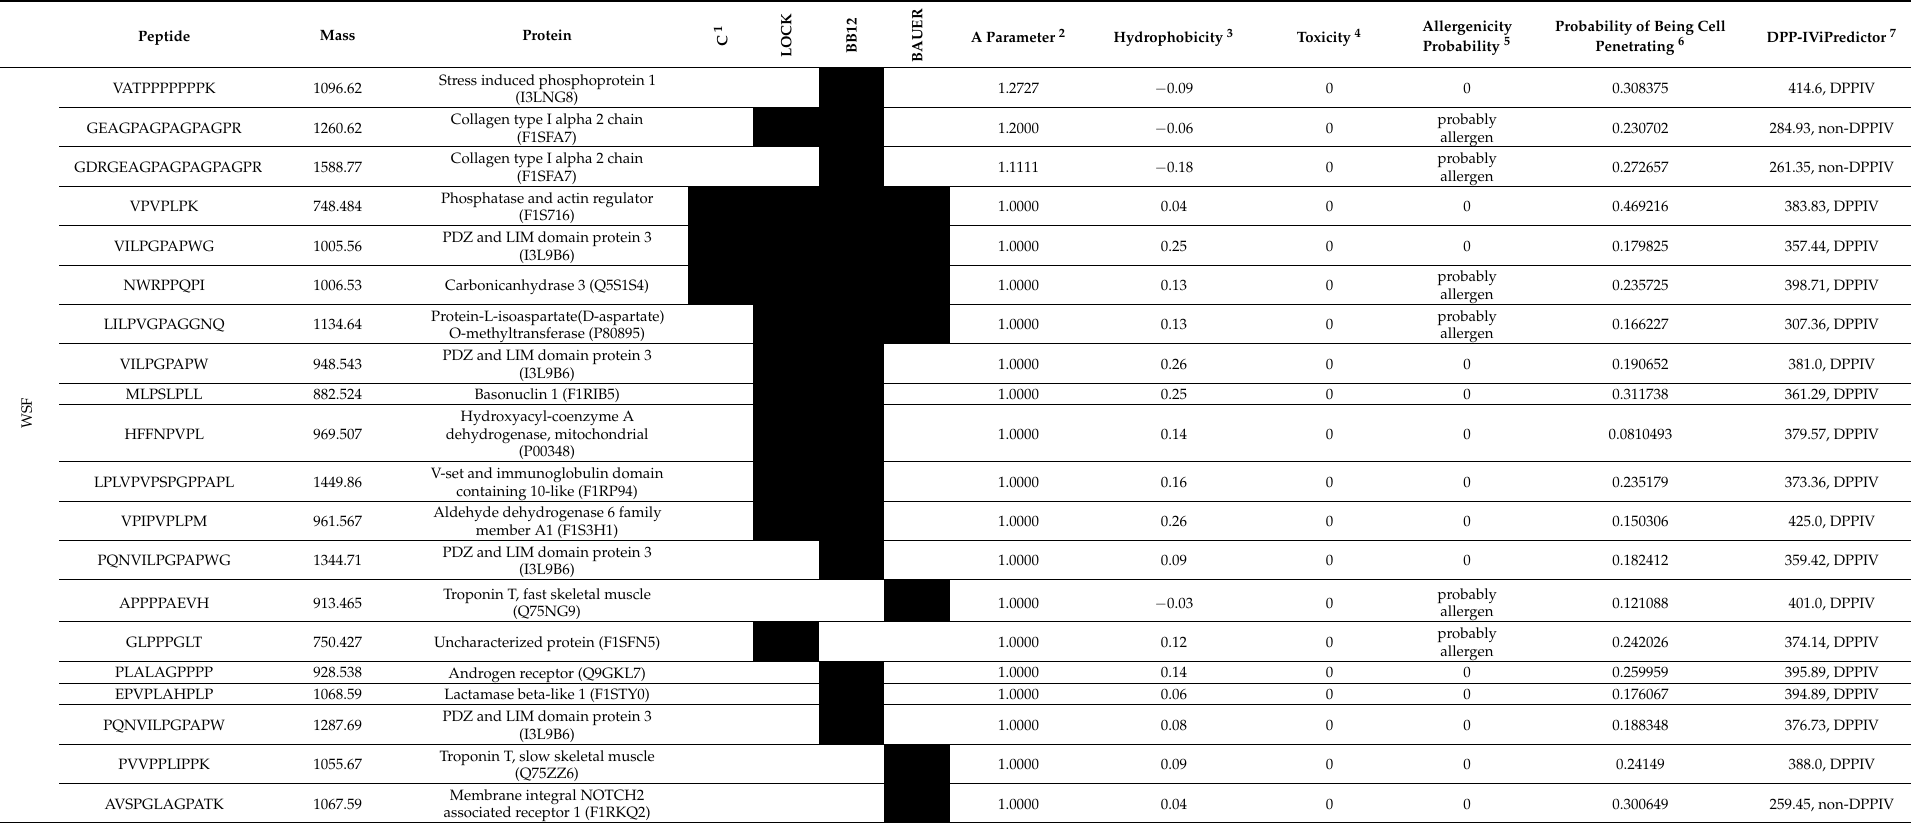
Table 5. List of the peptide sequences with the highest potential for DPP-IVi activity (A parameter higher than 1) after the